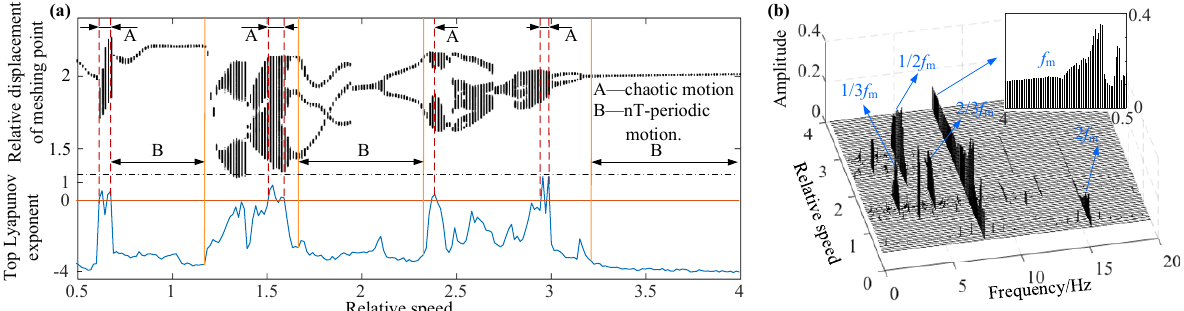
Figure 2. System response diagram. ( a ) System bifurcation diagram and top Lyapunov diagram. ( b ) Three-dimensional spectrum diagram.